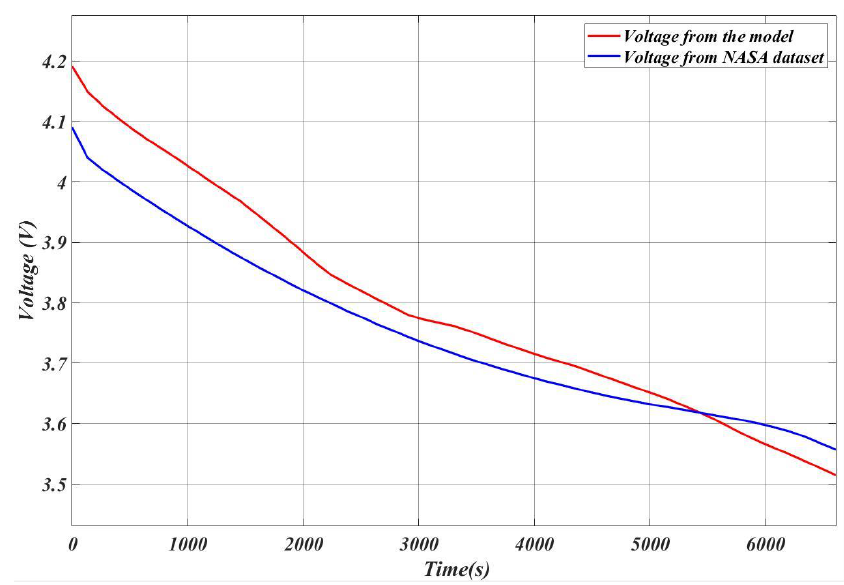
Electronics 2022 , 11 , x FOR PEER REVIEW Figure 9. Terminal voltages for pulse discharge profile. Figure 9. Terminal voltages for pulse discharge profile.